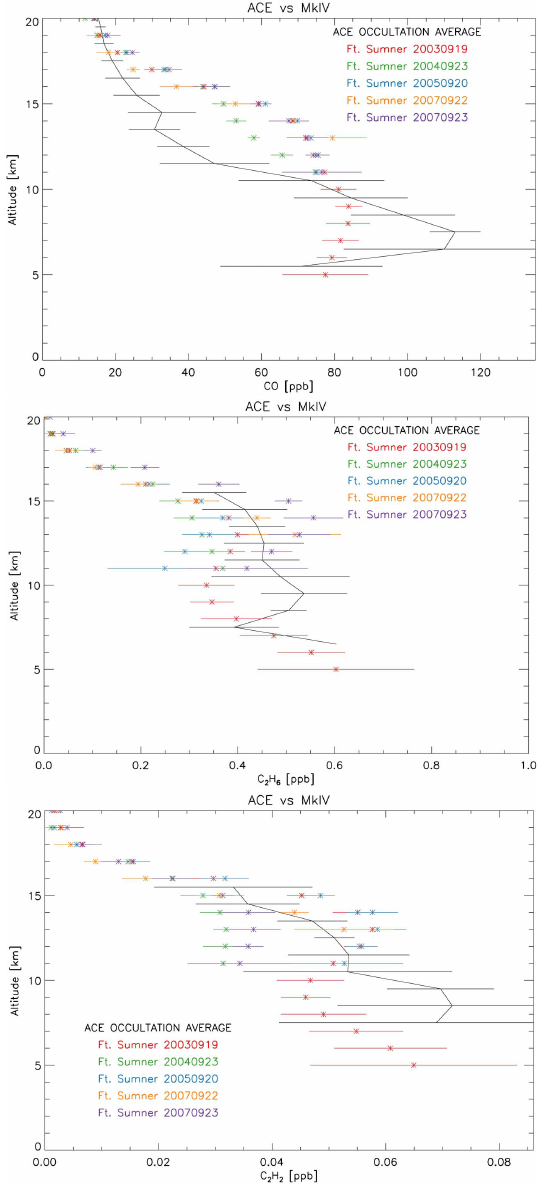
Fig. 6. Comparison of ACE-FTS average profiles and GTE, TRACE-A aircraft field campaign concentrations of CO, top panel, C 2 H 6 middle panel and C 2 H 2 lower